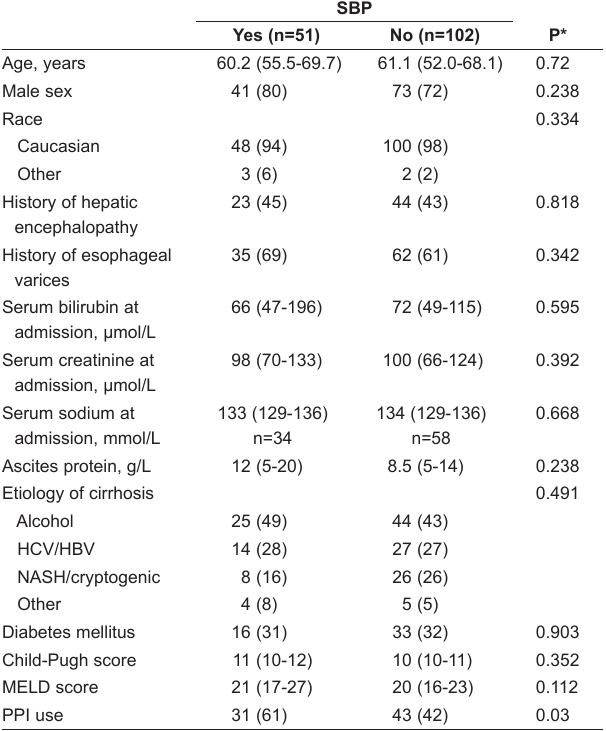
TAble 1 Demographic, clinical and laboratory data from patients with spontaneous bacterial peritonitis (SbP) and controls